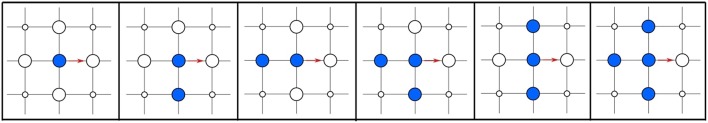
Hopping diffusion process (red arrow) of a particle on a quadratic lattice for all possible configurations of the nearest neighbor lattice sites in the initial state. Configurations that are equivalent by symmetry are shown only once. The site where the particle diffuses to must be empty for the process to be possible.